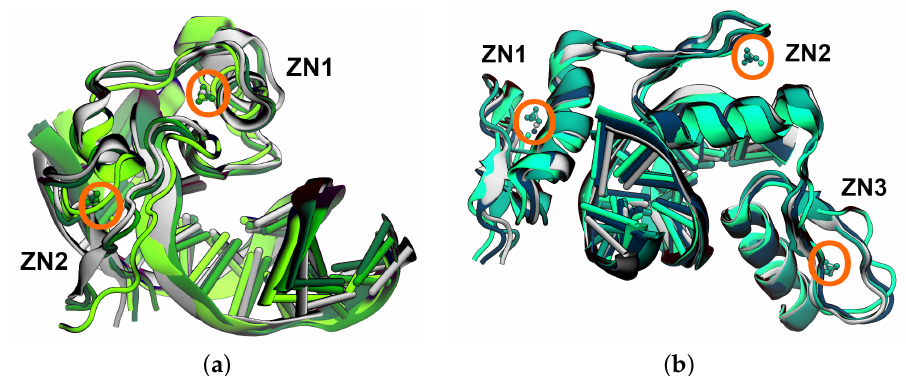
Figure 1. Representative median structures (coloured) of the simulations with the three ion models aligned (protein and DNA backbone) to the respective crystal structure (grey) of ( a ) MLL1 (PDB ID: 4nw3 [35,37]) and ( b ) WT1 (PDB ID: 5kl2 [34,36]). The colours represent (from light to dark) the non-bonded 12-6-4 model, the CDAM, and the bonded EZAFF model. Zn 2 + -ions are highlighted with orange circles. For a detailed view of the coordination geometry of the Zn 2 + -ions, see Figure 6. For median structures of the last 100 ns of all runs, see Figures S10 and S11 for MLL1 and WT1,